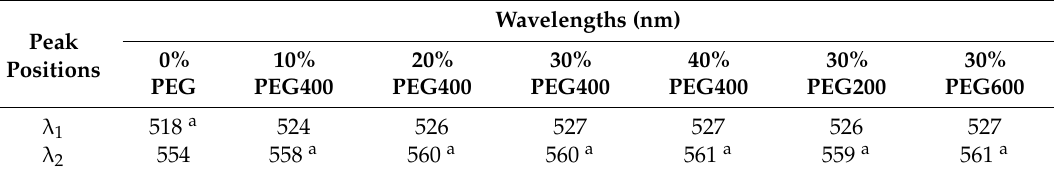
Figure 3. The hydrophobic interaction of PEG and dye molecules and the separation effect of PEG macromolecules. Table 1 lists all the peak positions for different dye solutions. It is clear that the maximum absorption peak of the dye solution, λ 1 , changed to λ 2 when PEGs were added to the solution due to the rapid increase of the peak height of λ 2 . Table 1. The absorption peak positions of PEG–dye aqueous solutions.